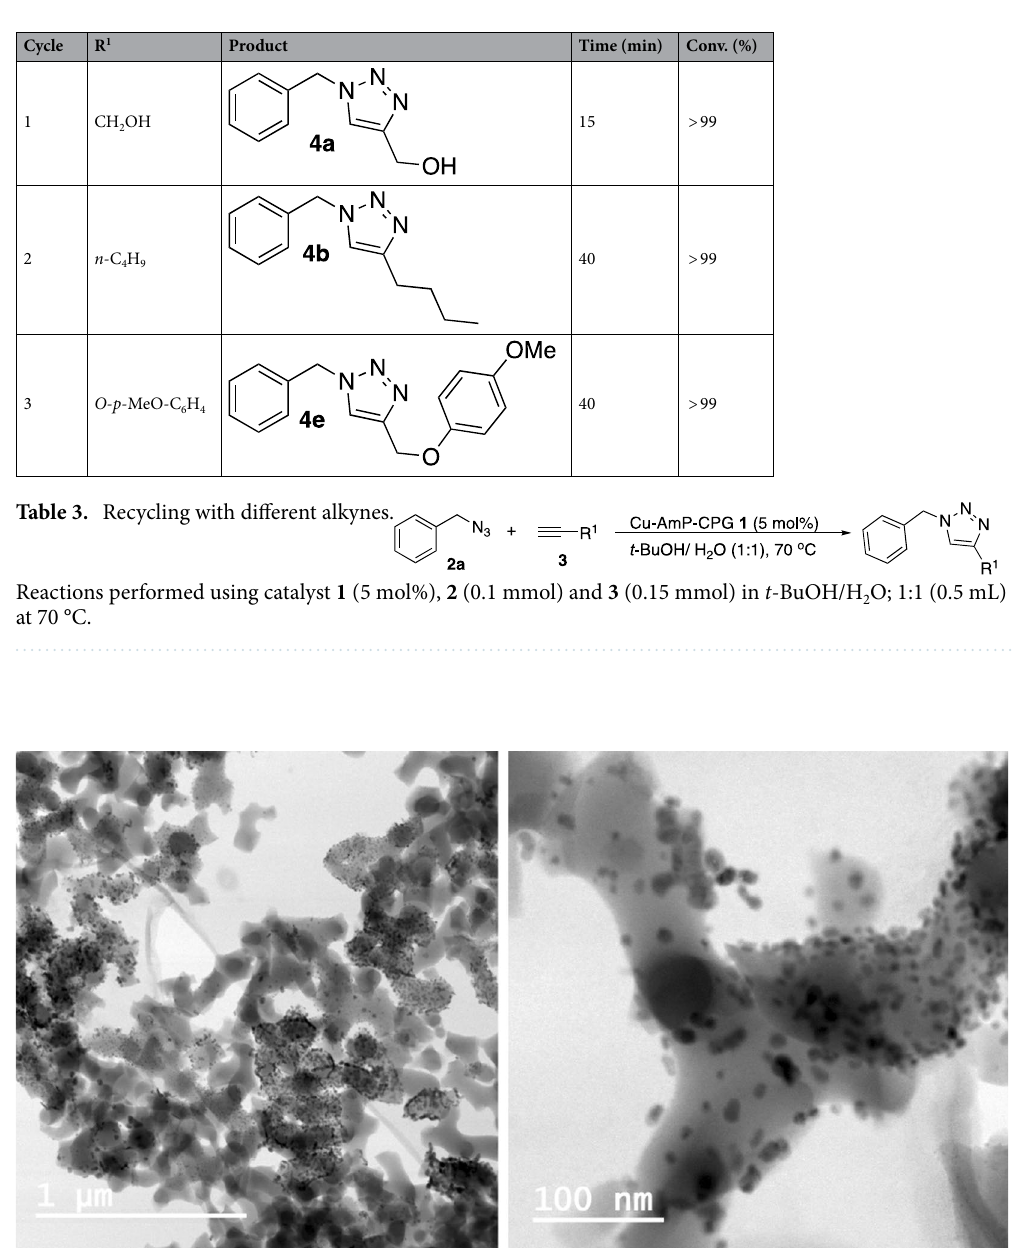
Figure 4. Transmission electron micrographs (TEM) of the mixed valence Cu-AmP-CPG nanocatalyst 1